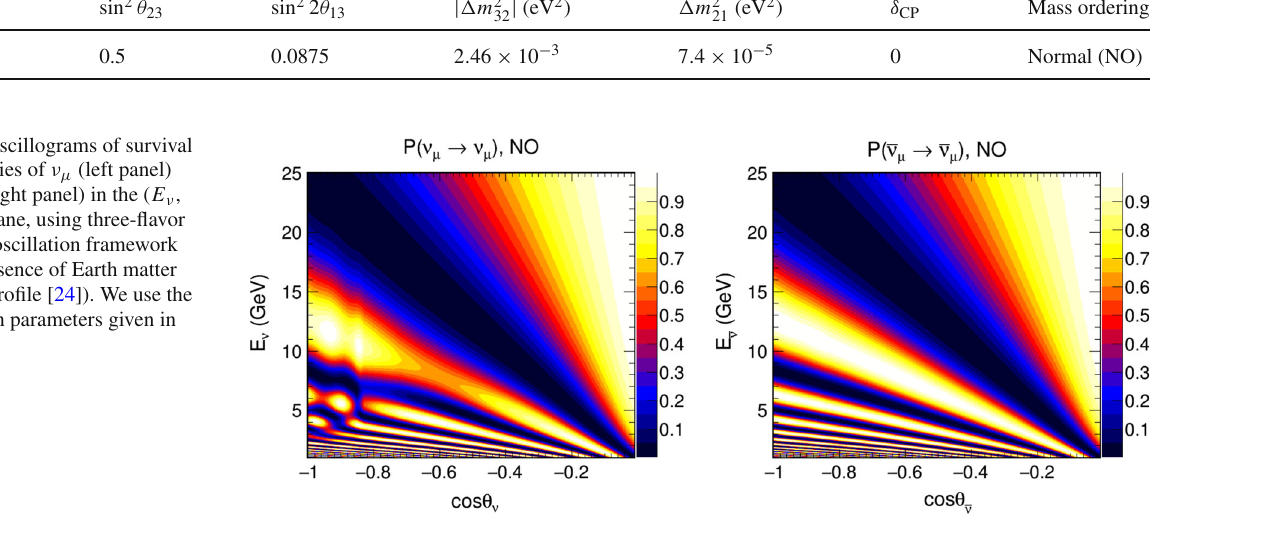
Fig. 1 The survival probabilities of ν μ (left panel) and ¯ ν μ (right panel) as functions of L ν / E ν , in the three-flavor neutrino oscillation framework in the presence of Earth matter (PREM profile [24]). Different colors represent different values of the neutrino zenith angle θ ν (or equivalently, the neutrino baseline L ν ). We use the oscillation parameters given in Table 1